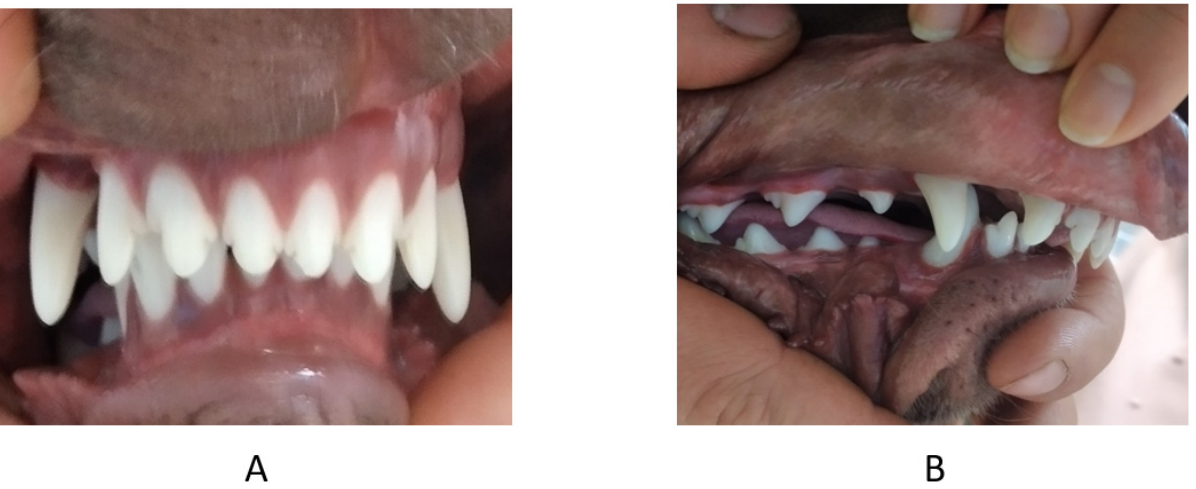
Figure 9. Third case. Intraoral photograph in full occlusion before the treatment. Visible asymmetry of arches with a disturbed plane. ( A ) en face, ( B ) right side.